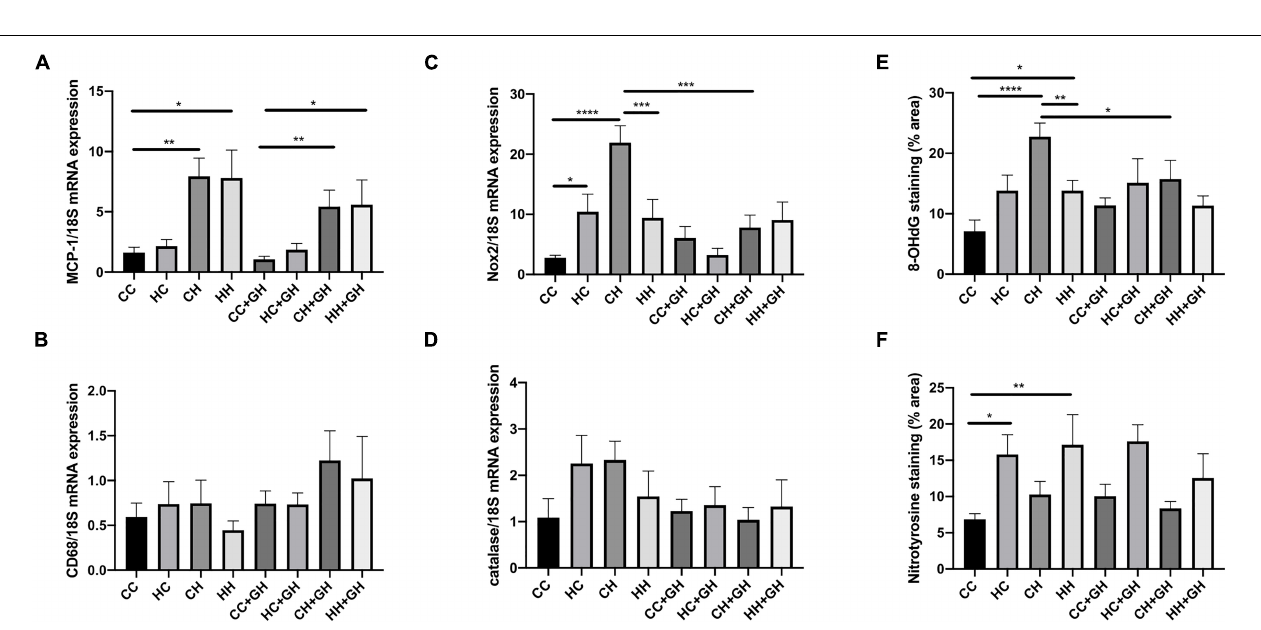
FIGURE 9 | Markers of renal inflammation and oxidative stress. (A) Renal MCP-1 mRNA expression, (B) renal CD68 mRNA expression, (C) renal Nox2 mRNA expression, (D) renal mRNA expression of catalase, (E) quantitation of renal immunohistochemistry staining for 8-OHdG, (F) quantitation of renal immunohistochemistry staining for nitrotyrosine. Results expressed as mean ± SEM, n = 6. * p < 0.05, ** p < 0.01, *** p < 0.001, **** p < 0.0001. CC, control offspring; HC, lean offspring of obese mothers; CH, obese offspring of lean mothers; HH, obese offspring of obese mothers; CC + GH, control offspring exposed to gestational hydralazine; HC + GH, lean offspring of obese mothers with gestational hydralazine; CH + GH, obese offspring of lean mothers with gestational hydralazine; HH + GH, obese offspring of obese mothers with gestational hydralazine.